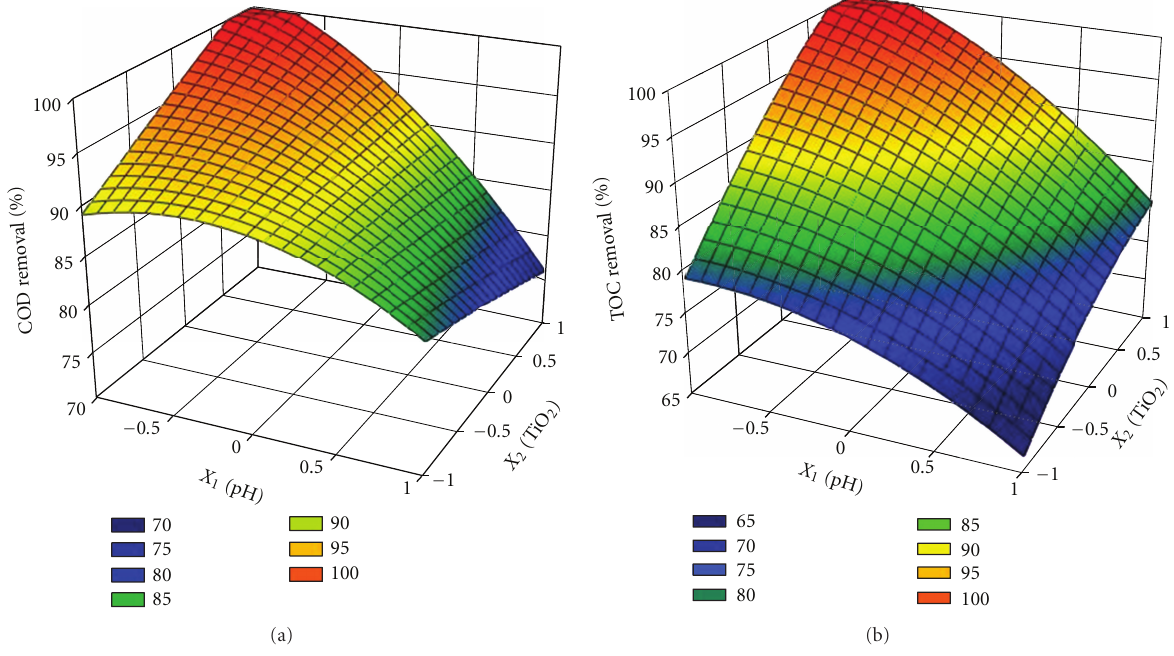
Figure 2: Response surface for (a) COD and (b) TOC degradation e ffi ciency of AO10 wastewater as a function of initial pH and TiO 2 concentration. (Reaction time: 2h, light intensity (UV 280–400nm : 66.5 W/m 2 , water temperature: 25 ± 0 . 5 ◦ C).